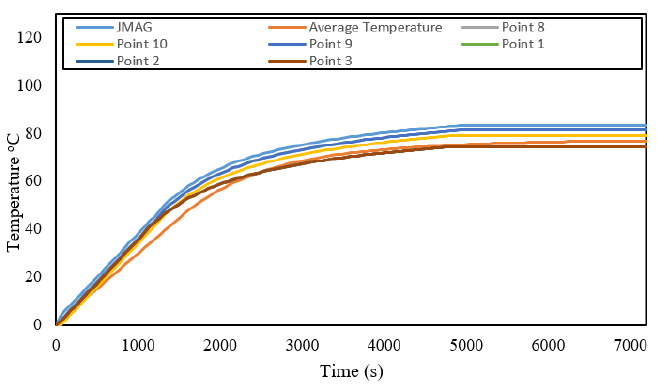
Figure 29. Temperature variation at different points of the machine.